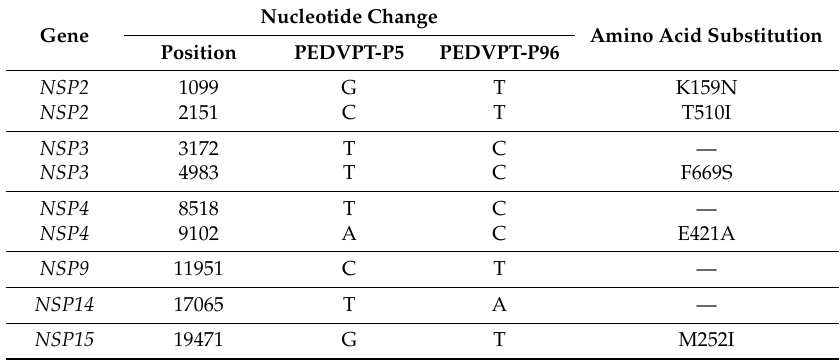
Table 2. Changes in nucleotides and amino acid between PEDVPT-P5 and PEDVPT-P96.